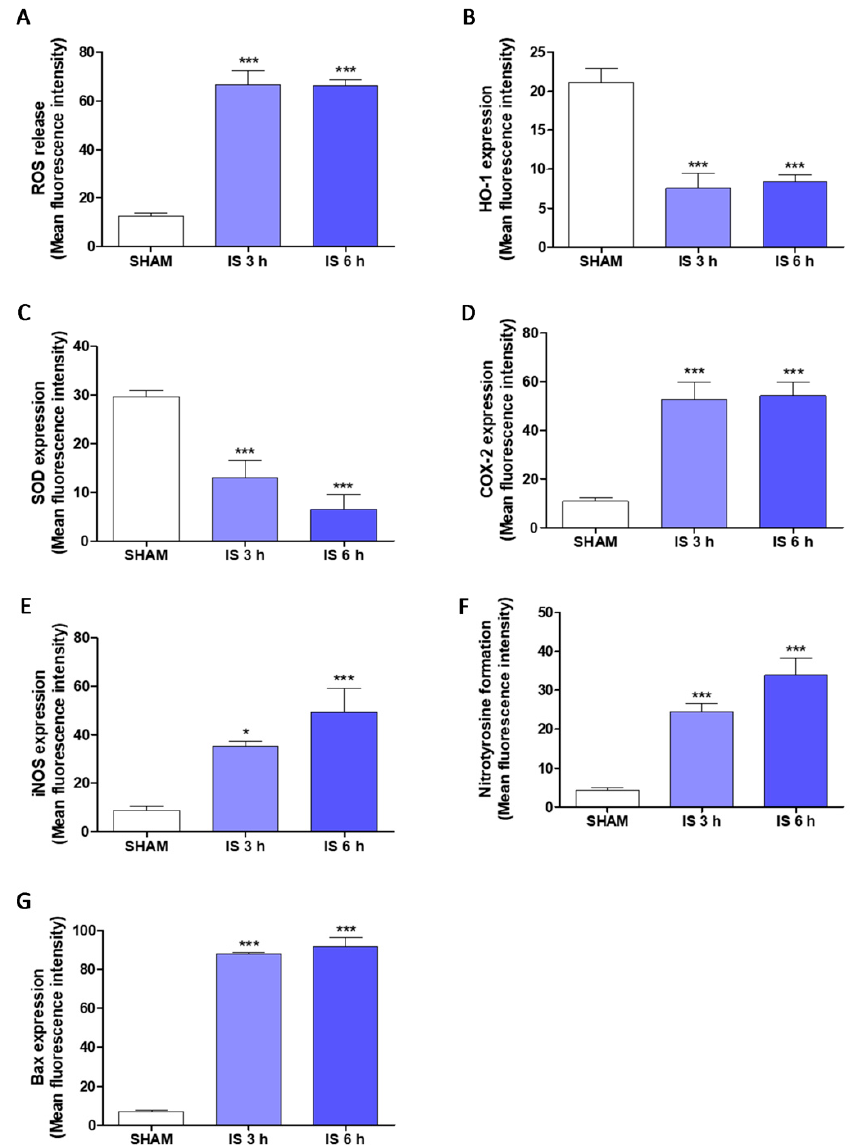
Figure 5. Effect of Indoxyl Sulfate (IS; 800 mg/kg; i.p.) on intracellular ROS release ( A ), evaluated by H 2 DCF-DA assay, HO-1 ( B ), SOD-2 ( C ), COX-2 ( D ), iNOS ( E ), nitrotyrosine ( F ), and Bax ( G ), evaluated by the cytofluorimetric technique, on primary murine peritoneal macrophages. Data are expressed as mean of fluorescence intensity. *** and * denote respectively p < 0.001 and p < 0.05 vs SHAM.